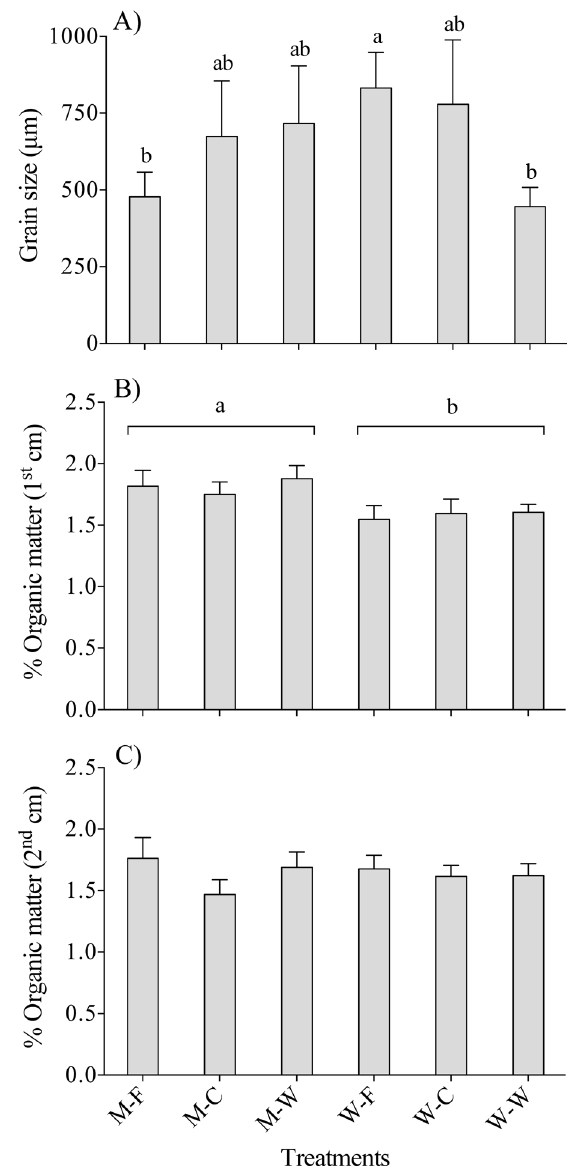
Fig. 2. Mean (A) sediment grain size (±SE, n = 8) in the top 2 cm of the sediment and mean organic matter percentage in the (B) first (surficial) and (C) second centimetre of the sediment (±SE, n = 8). Treatments are combinations of presence (M) or absence (W) of Manila clams Venerupis philippinarum and anti-predator net status (F: fouled; C: cleaned; W: without). Different letters above bars indicate significant (p <0.05) differences between treatment